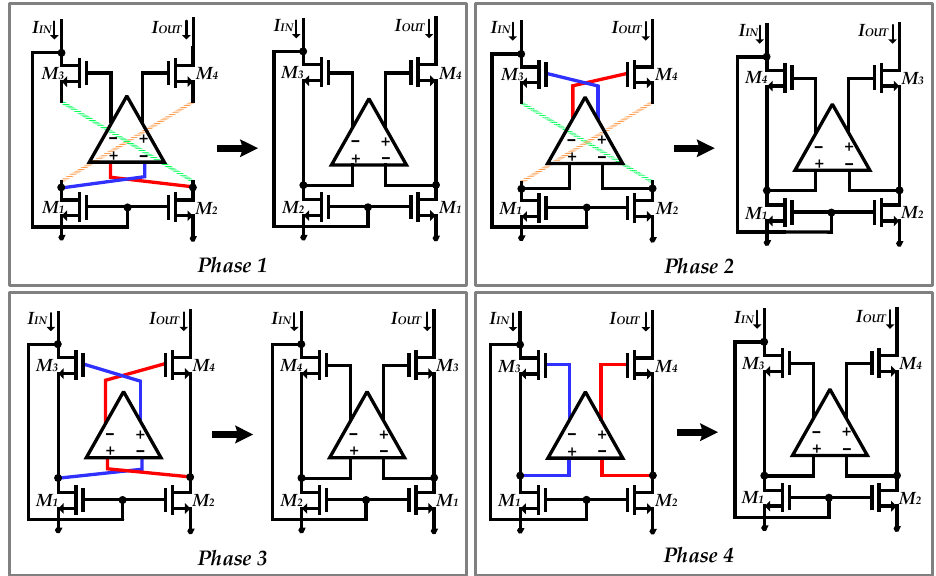
Figure 5. Operation principles of chopper and DEM technique.